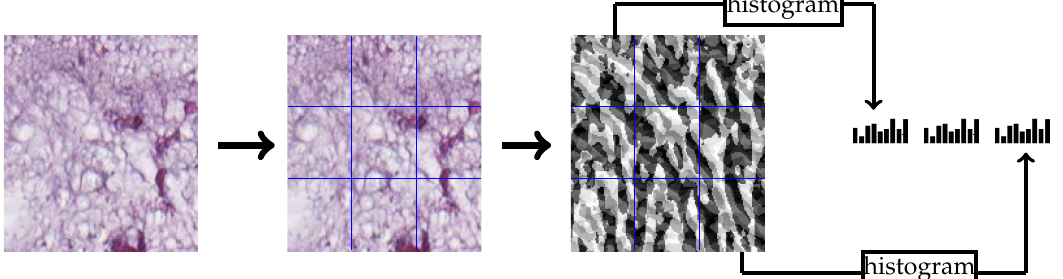
Figure 4. Multi-block BSIF feature extraction example of 3 × 3 multi-block